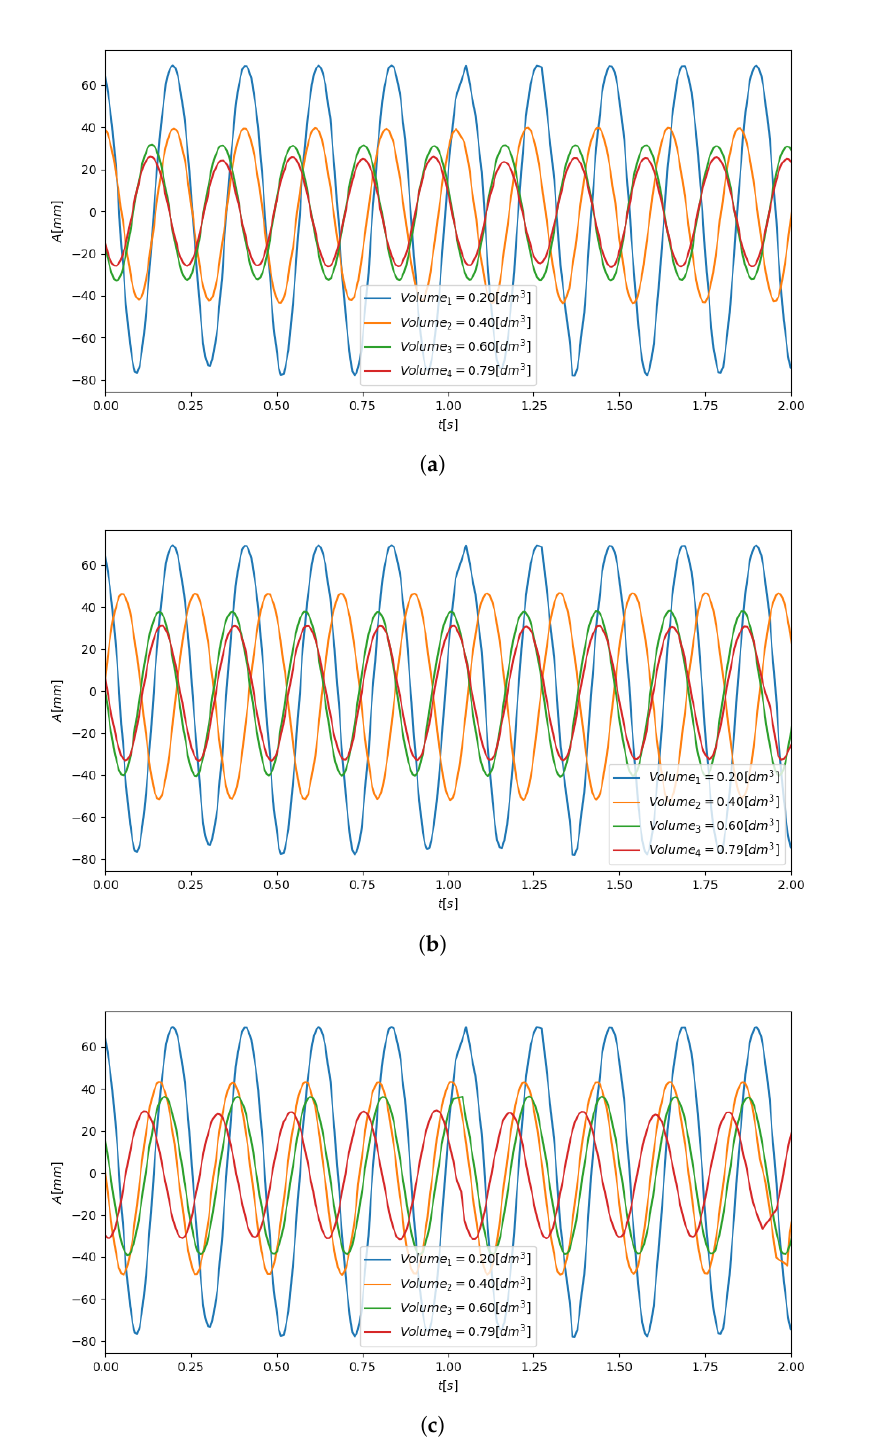
Figure 6. Displacement waveforms for various composition of the grains. ( a ) Beam displacements—steel grains; ( b ) Beam displacements—plastic grains; ( c ) Beam displacements—mixed